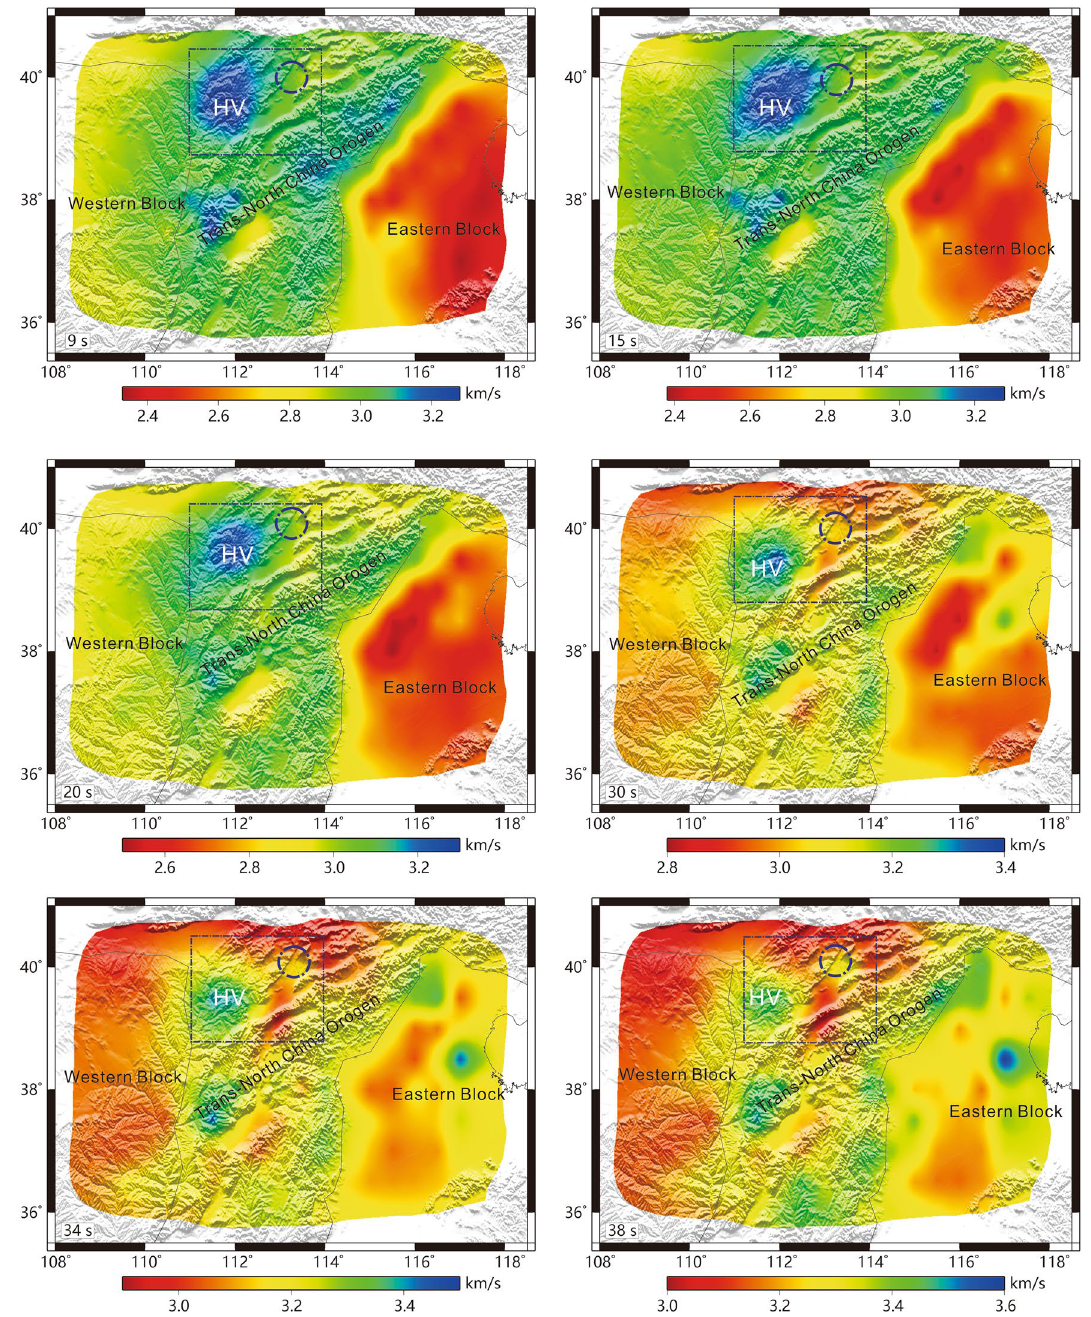
Figure 3. Rayleigh wave group velocities at six different periods. Blue circle: Datong volcano group. The black lines are the boundaries of geological units. Rectangle region: Cenozoic basalt region [the figure was generated by Chuansong He using Generic Mapping Tools (https:// www. gener ic- mappi ng- tools.